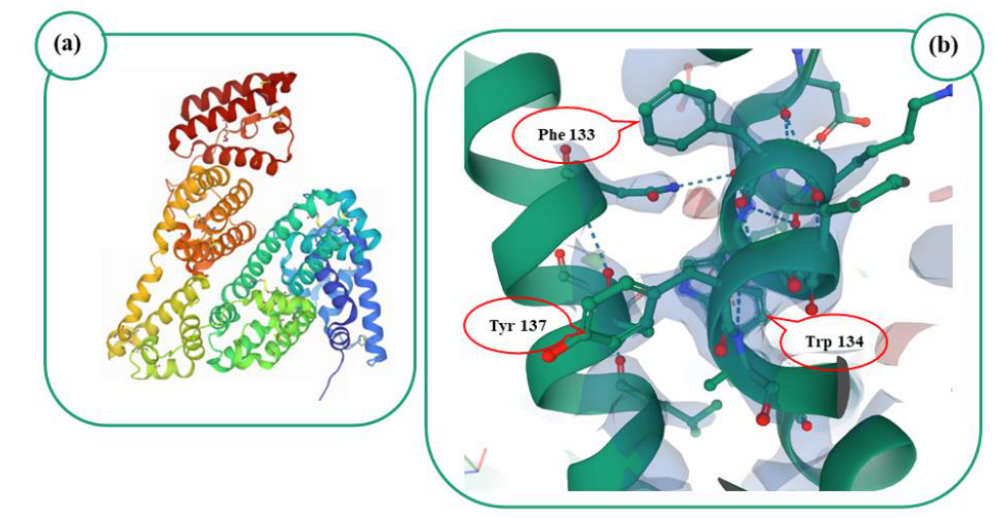
Figure 7. ( a ): Image from the RCSB Protein Data Bank (PDB) of PDB ID 4F5S [161], IUCr (2012). ( b ): Image of tryptophan (Trp), phenylalanine (Phe) and tyrosine (Tyr) residues occurring in 4F5S, Mol*.